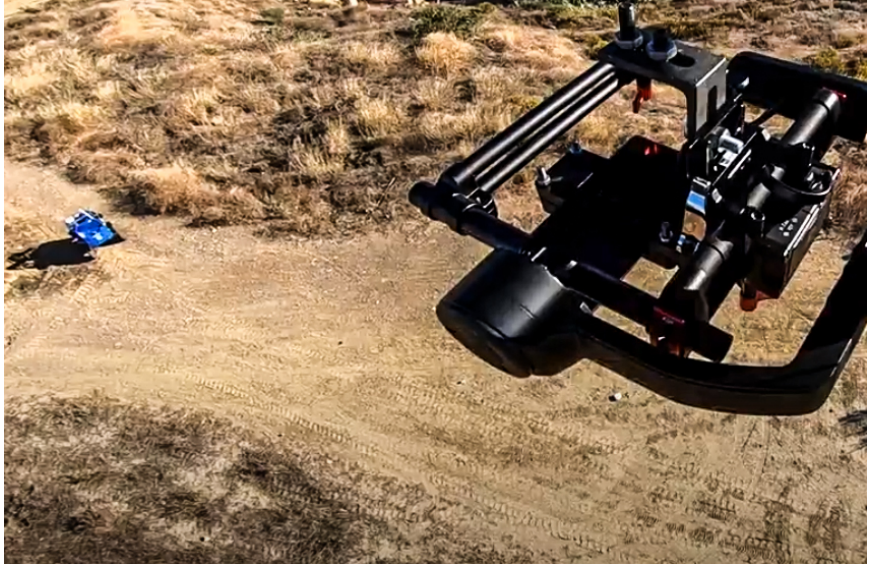
Figure 11. Rambler’s static position from the